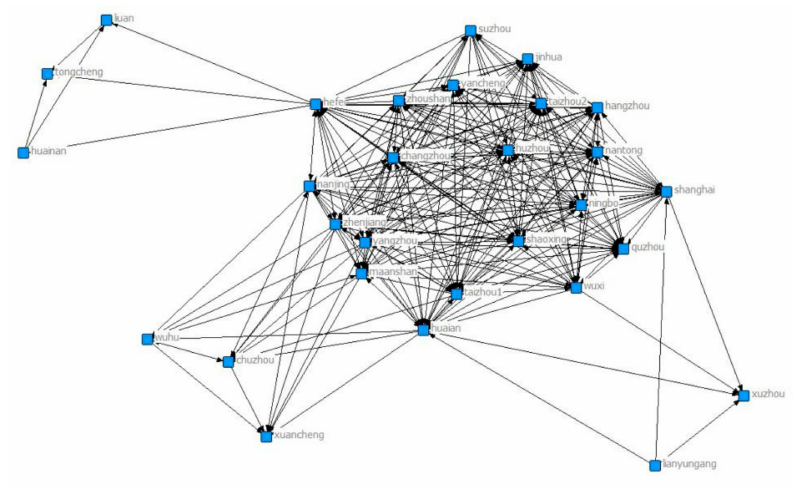
Figure 5. Yangtze River Delta collaborative network in 2013.